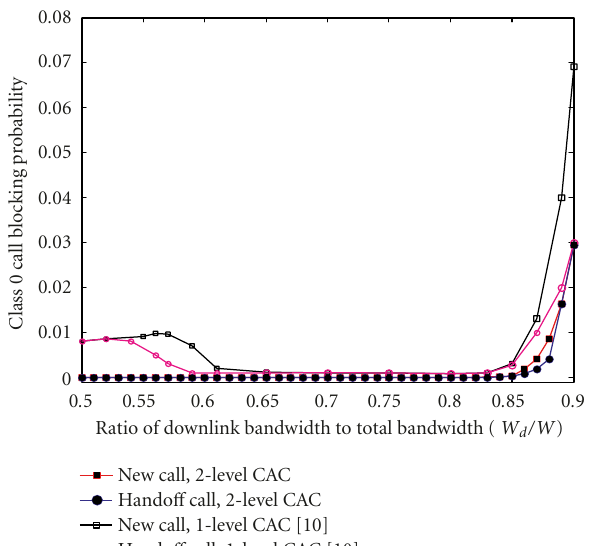
Figure 2: Class 0 call blocking probabilities versus W d /W ( Λ = 0 . 1, W res /W = 0 . 1)